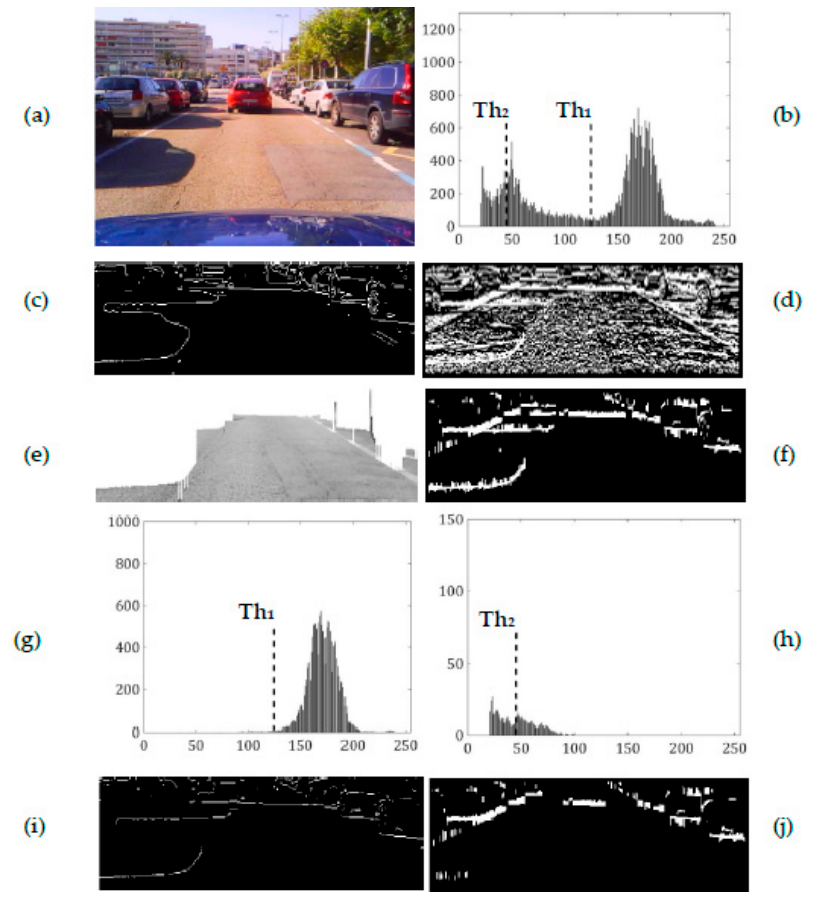
Figure 10. Road scene on a sunny day. ( a ) searched image area, ( b ) its greyscale histogram. Left column (method proposed in [21]): ( c ) edge map, ( e ) free driving road, ( g ) histogram of the free driving road and ( i ) edge map after intensity thresholding. Righ column (our method): ( d ) vertical intensity gradients, ( f ) M ( x , y ) after application of saturation and intensity constraints, ( h ) histogram of set of upper pixels of the gradients and ( j ) M ( x , y ) after intensity thresholding.